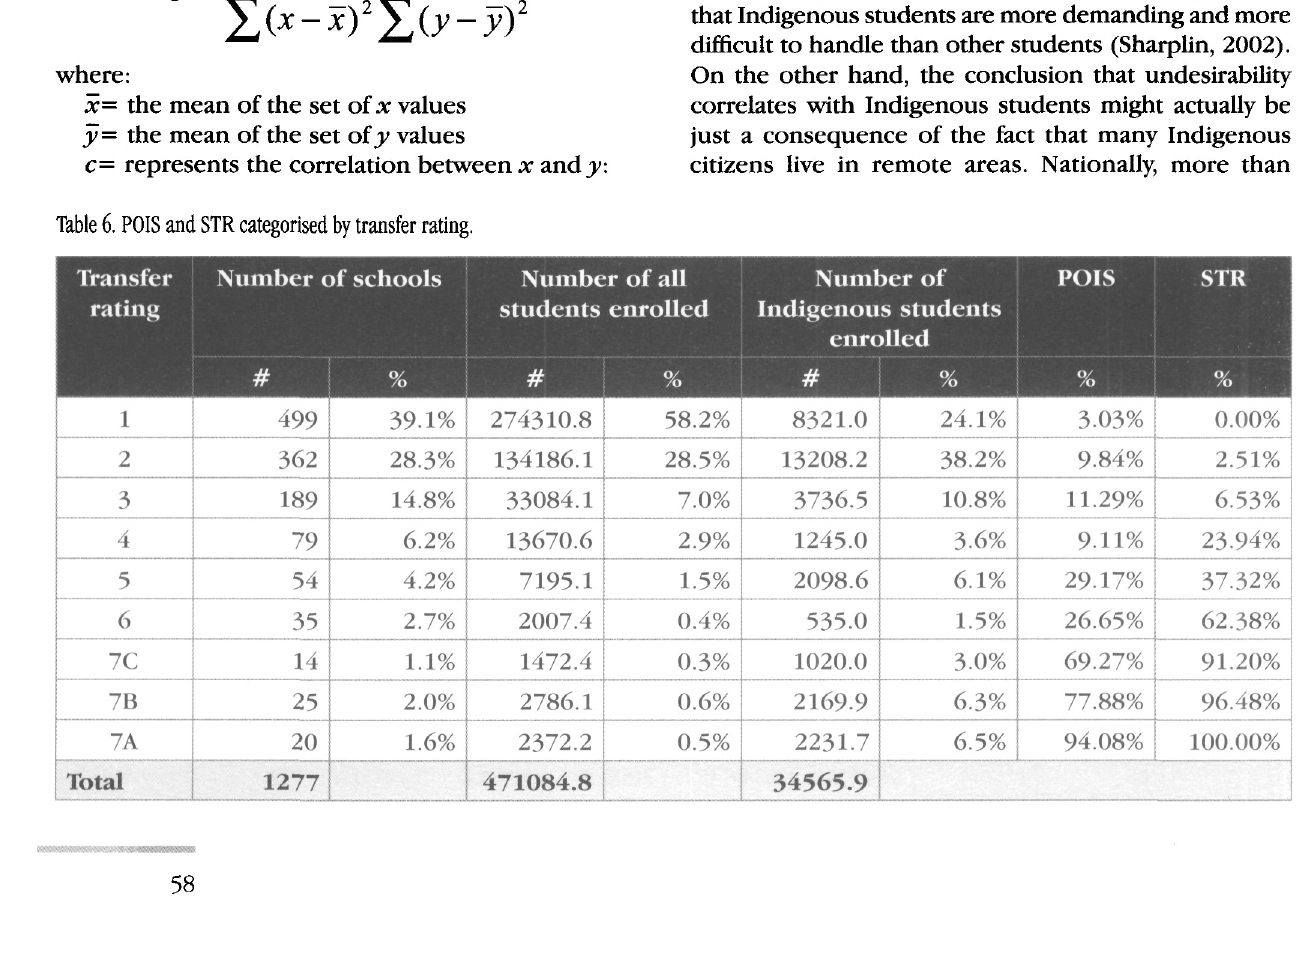
Table 6. POIS and STR categorised by transfer